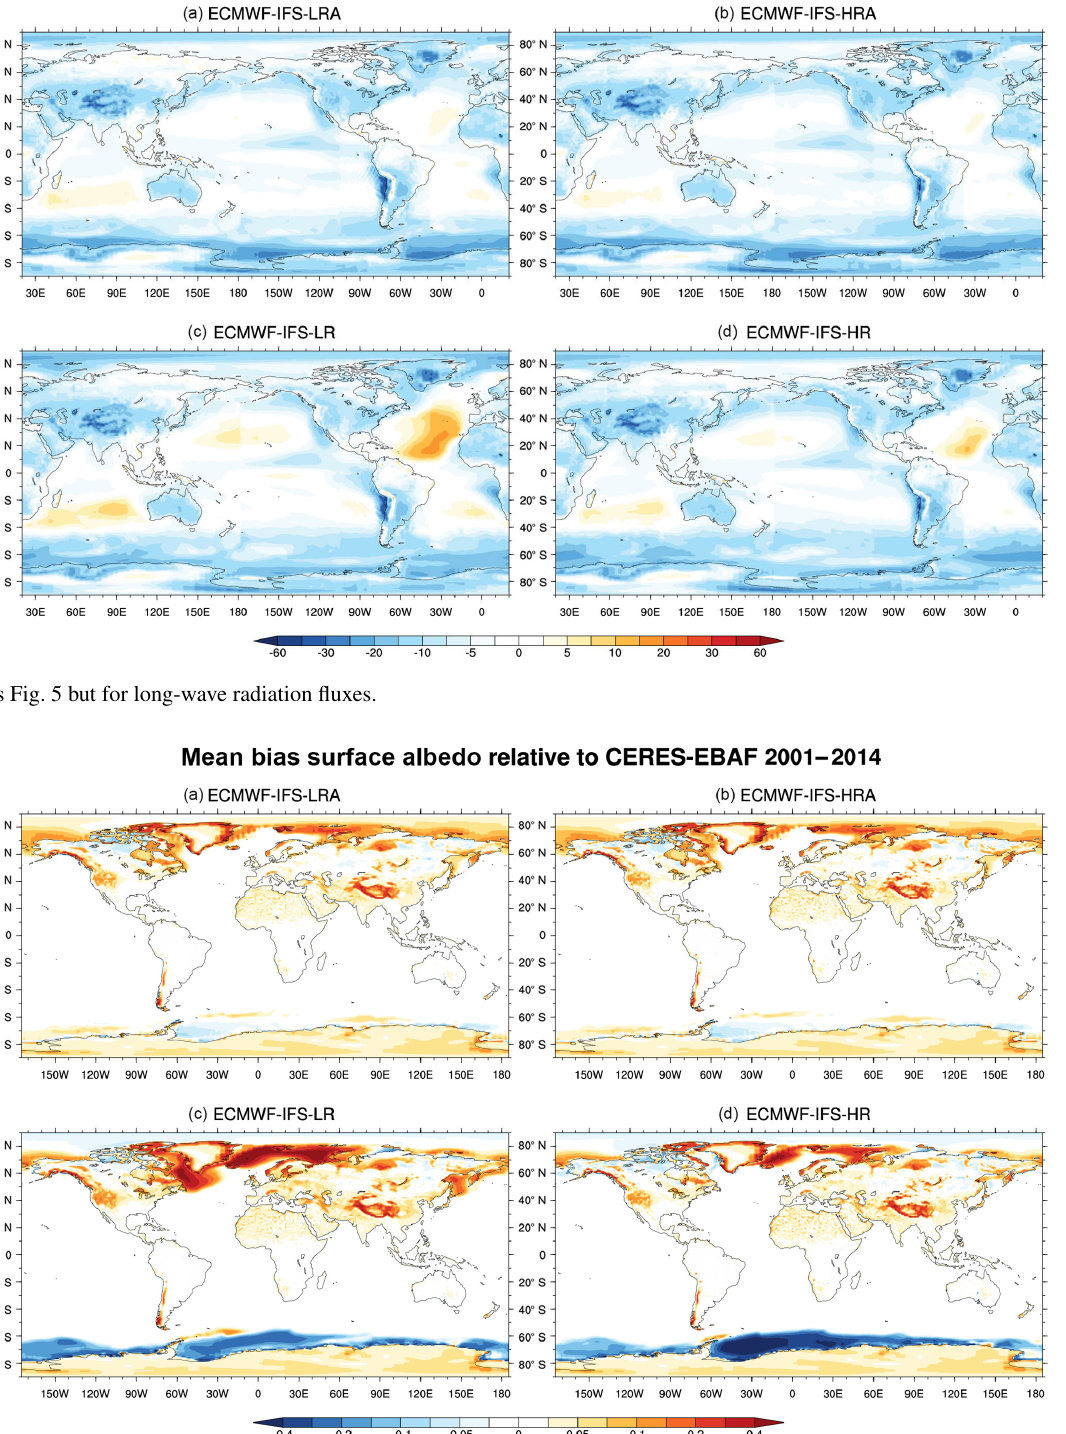
Figure 8. Mean bias in short-wave surface albedo in (a–b) highresSST-present and (c–d) hist-1950 relative to estimates derived from CERES- EBAF surface fluxes edition 4.0 (Kato et al., 2013). Surface albedo is defined to be α sfc = SW up / SW down , where SW down is the short-wave radiation at the surface and SW up is upward short-wave radiation at the